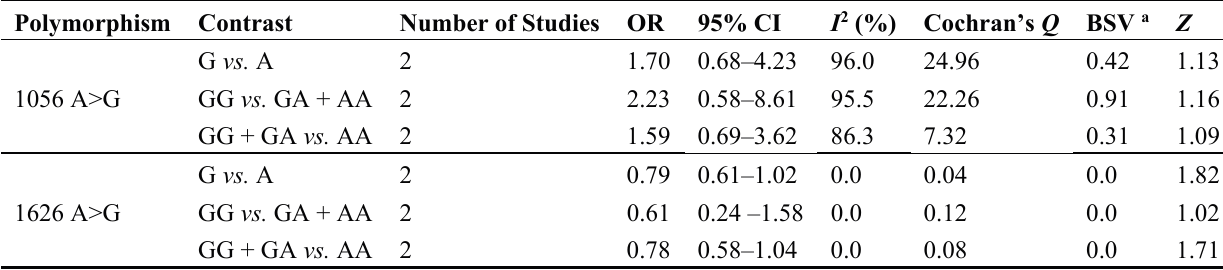
Table 7. Univariate meta-analysis for the 1056 A>G and 1626 A>G polymorphisms of the CD24 gene with multiple